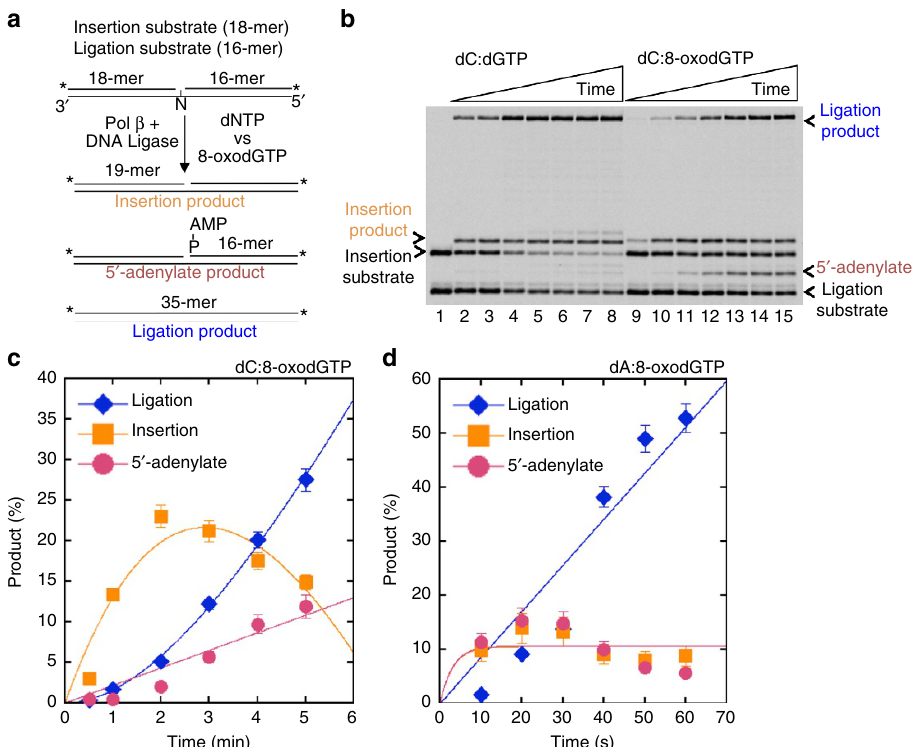
Figure 1 | Effect of pol b 8-oxodGMP insertion on ligation. ( a ) Illustrations of DNA substrates and reaction products for insertion, ligation, and 5’-adenylation observed in a coupled BER assay. ( b ) Lane 1 is the minus enzyme control for the substrate C gap , lanes 2–8 and 9–15 are the reaction products in the presence of dGTP and 8-oxodGTP, respectively, and correspond to time points of 0.5, 1, 2, 3, 4, 5 and 6min. Plots show time-dependent changes in the products of 8-oxodGMP insertion, ligation, and 5’-adenylation for the substrates C gap ( c ) and A gap ( d ). Quantification of the products for dC:dGTP is presented in Supplementary Fig. 1a. The data represent mean values with the s.d. from three independent